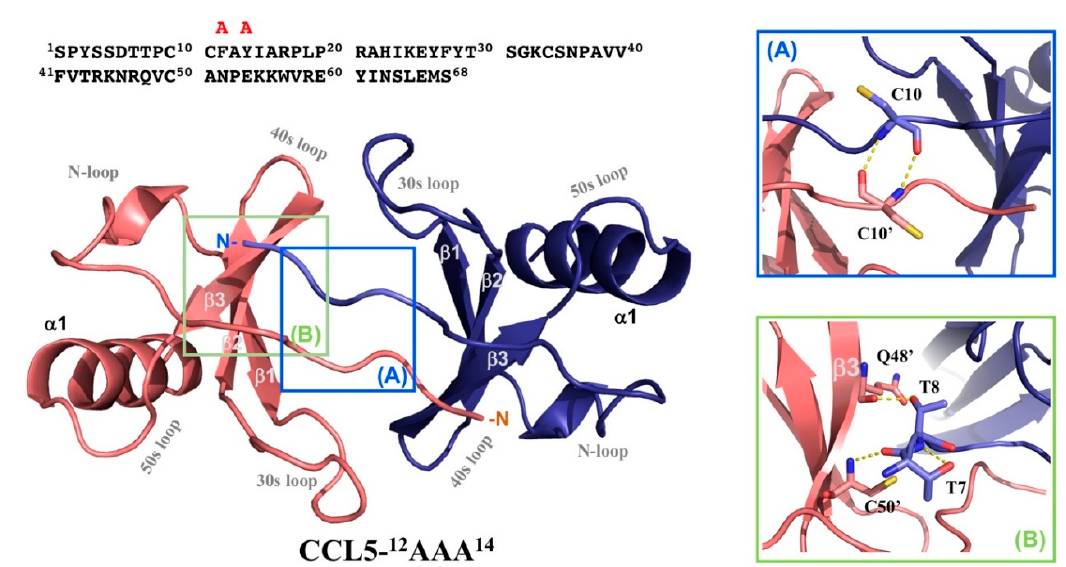
Figure 3. Crystal structure of CCL5- 12 AAA 14 . The structure of CCL5- 12 AAA 14 solved with a resolution of 2.55 Å adopts typical chemokine fold with three β -sheets and one α -helix. The dimer structure packs with two-fold symmetry. The secondary structural elements and the connecting loops are indicated. The detailed interactions in the interfacial contact region between the two monomers are depicted in ( A ) and ( B ).